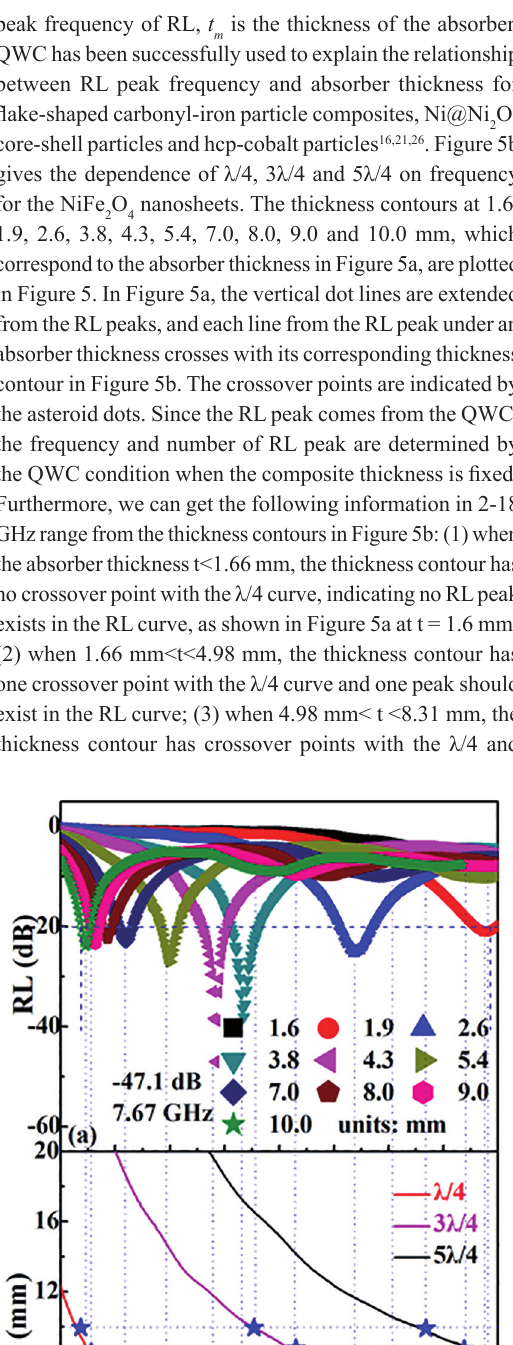
O 2 4 and μ with r r